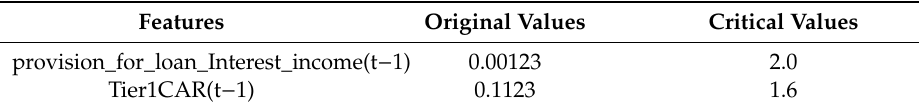
Table 5. Features, original values, and critical